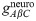
Investigating the weighting parameter, gAβCneuro.A: Percent of the mean and B: average firing rate of the PNs in response to changes in the strength of excitation, during neuropathy, from the Aβ- fibers to the C-fibers, gAβCneuro (denoted by gAβC in the figure). The x-axis refers to hours since the typical or scheduled morning wake time.